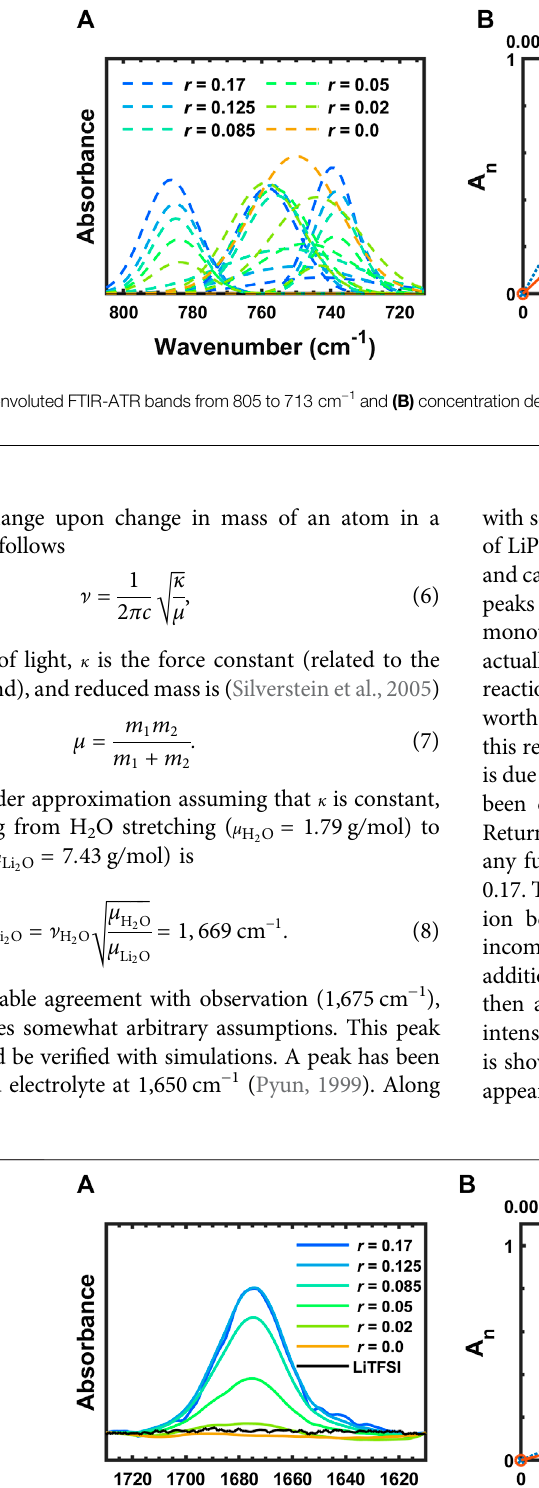
Frontiers in Energy Research |